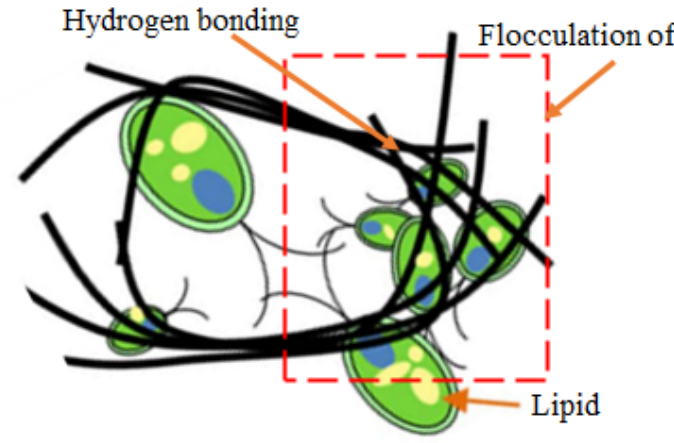
Figure 9. Schematic design of CNF induced microalgal flocculation. This figure was adapted from [122].